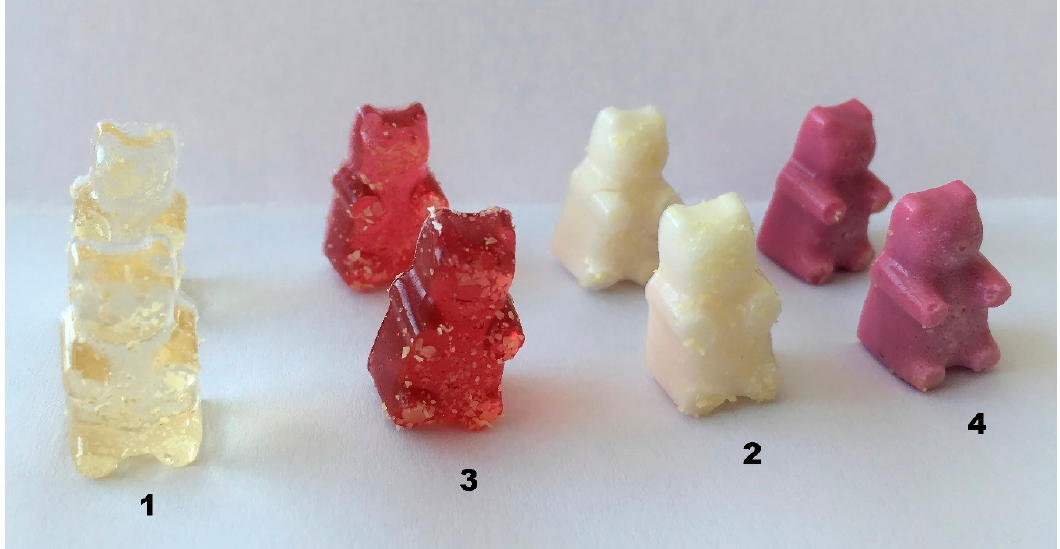
Molecules 2019 , 24 , x FOR PEER REVIEW